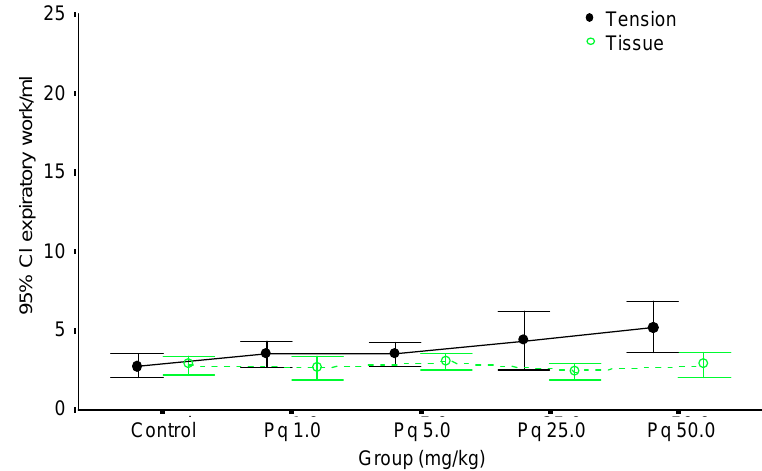
Figure 5 - Mean values (circles) and corresponding standard errors (lines) of the 95% confidence interval (CI) of expiratory work attributable to surface tension and tissue forces in control animals and in animals submitted to different doses of paraquat (Pq)